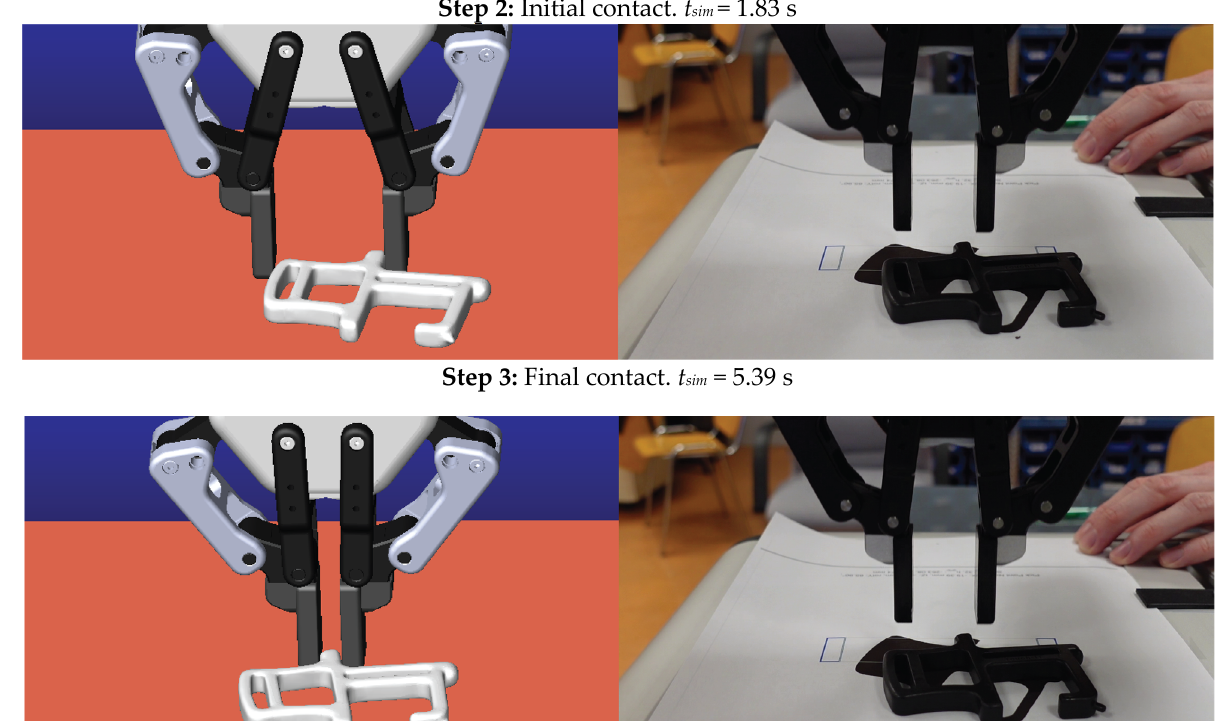
Figure 15. Contact forces between the left and right fingers and the object (red and blue line), and the contact force between the object and the ground (black line) for the first pick-point. The orange circles indicate the events on Figure 14. The dashed line indicates the desired contact force. Source: own. As can be seen from Figure 14, the robotic gripper starts grasping the object at around t sim = 5.39 s, and the contact force increases to a small value of around C LF-O = 0.05 N. At around t sim = 9.52 s, the initial contact force is increased to around 49 N since the two bodies (the left gripper finger and the object) come into contact. In the next few milliseconds, the force controller controls the contact force and maintains it for another second. However, when lifting the object starts, the object begins to slip from the gripper fingers; therefore, the contact force C LF-O value suddenly drops to zero. 4.4.2. Analysis of pick-point N 2 From Figure 16, it can be seen that the gripper picked the object successfully in sim- ulation and on the physical test setup. The grasp quality score for the first pick-point is high compared to the first pick-point. The object in the simulation and its physical test setup behaves nearly identically. In the last step, the object starts slipping from the robotic